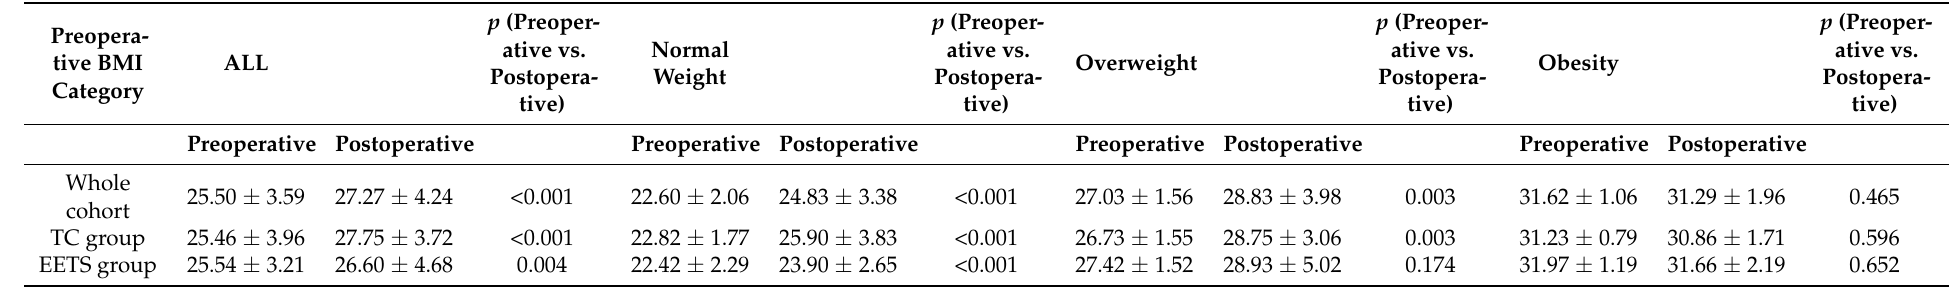
Table A1. The preoperative and postoperative BMI based on the preoperative BMI category in the adult-onset craniopharyngioma cohort. Compared with the TC group, patients with preoperative overweight yield a stable postoperative BMI in the EETS group (preoperative BMI, 27.42 kg/m 2 ; postoperative BMI, 28.93 kg/m 2